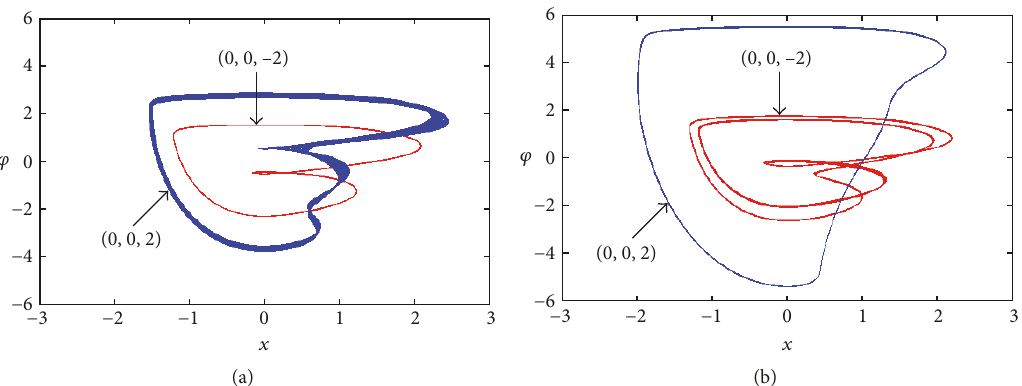
Figure 5: Phase portraits in the 𝑥 - 𝜑 plane for the other two types of hidden coexisting asymmetric attractors. (a) 𝐼 = 1 and 𝑘 = 0.735. (b) 𝐼 = 1 and 𝑘 = 0.81.